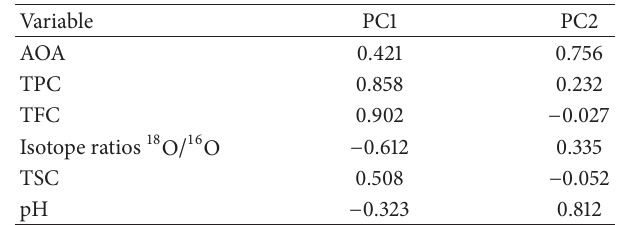
Table 2: The correlation matrix. Table 3: Loading of two-factor model that explains 64.37% of the total